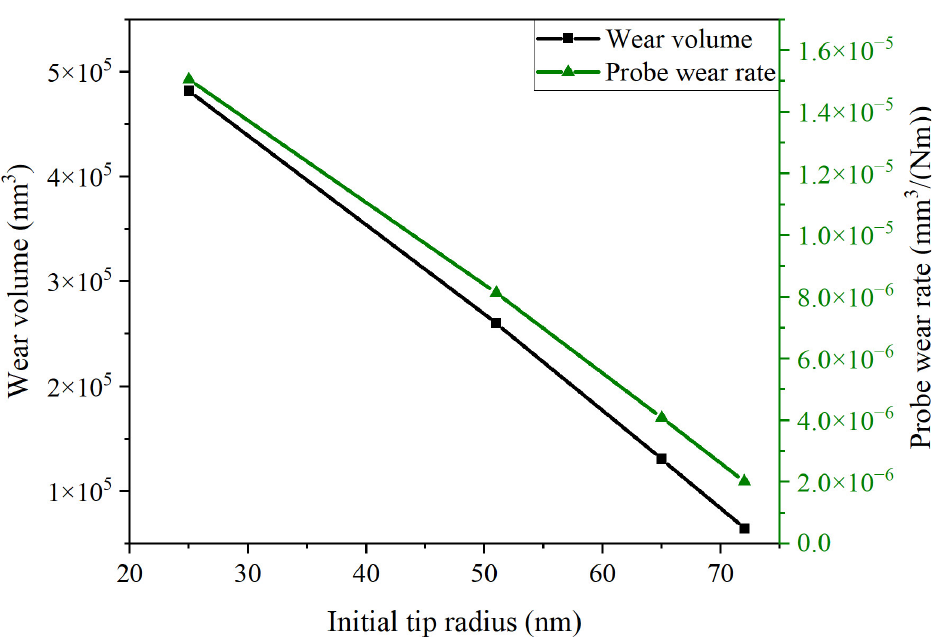
Figure 11. Relationship between the initial tip radius and the probe wear volume and probe wear rate.